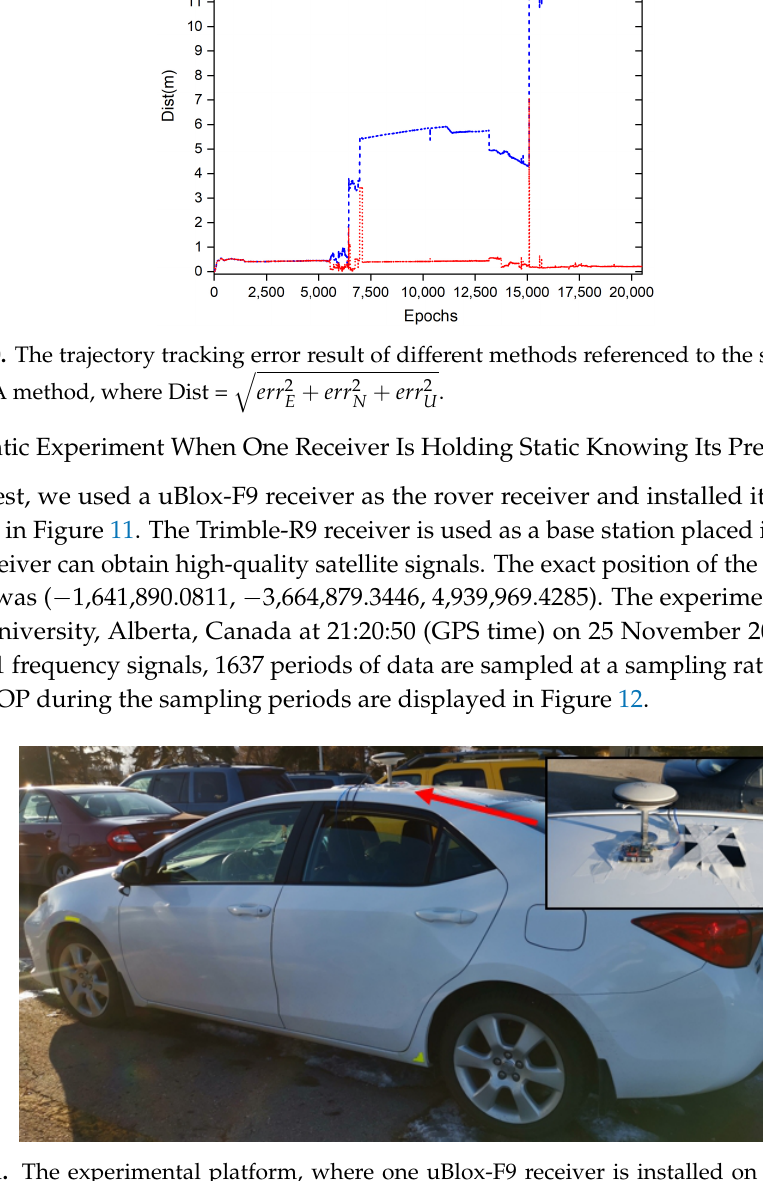
Figure 11. The experimental platform, where one uBlox-F9 receiver is installed on the top of the experimental